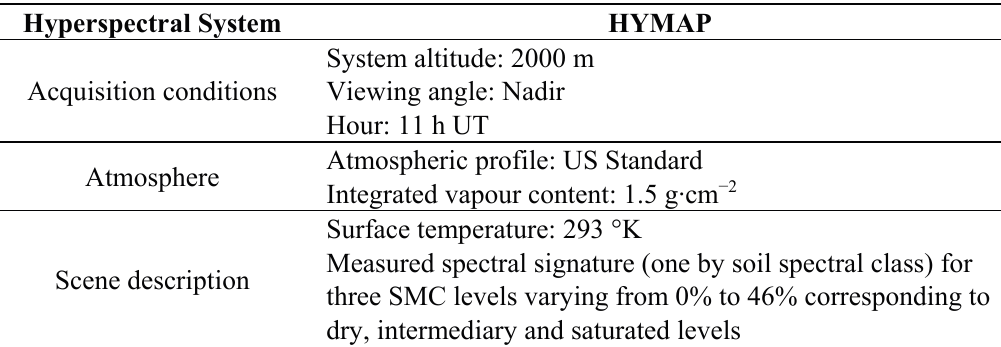
Table 6. Parameters of the nominal case